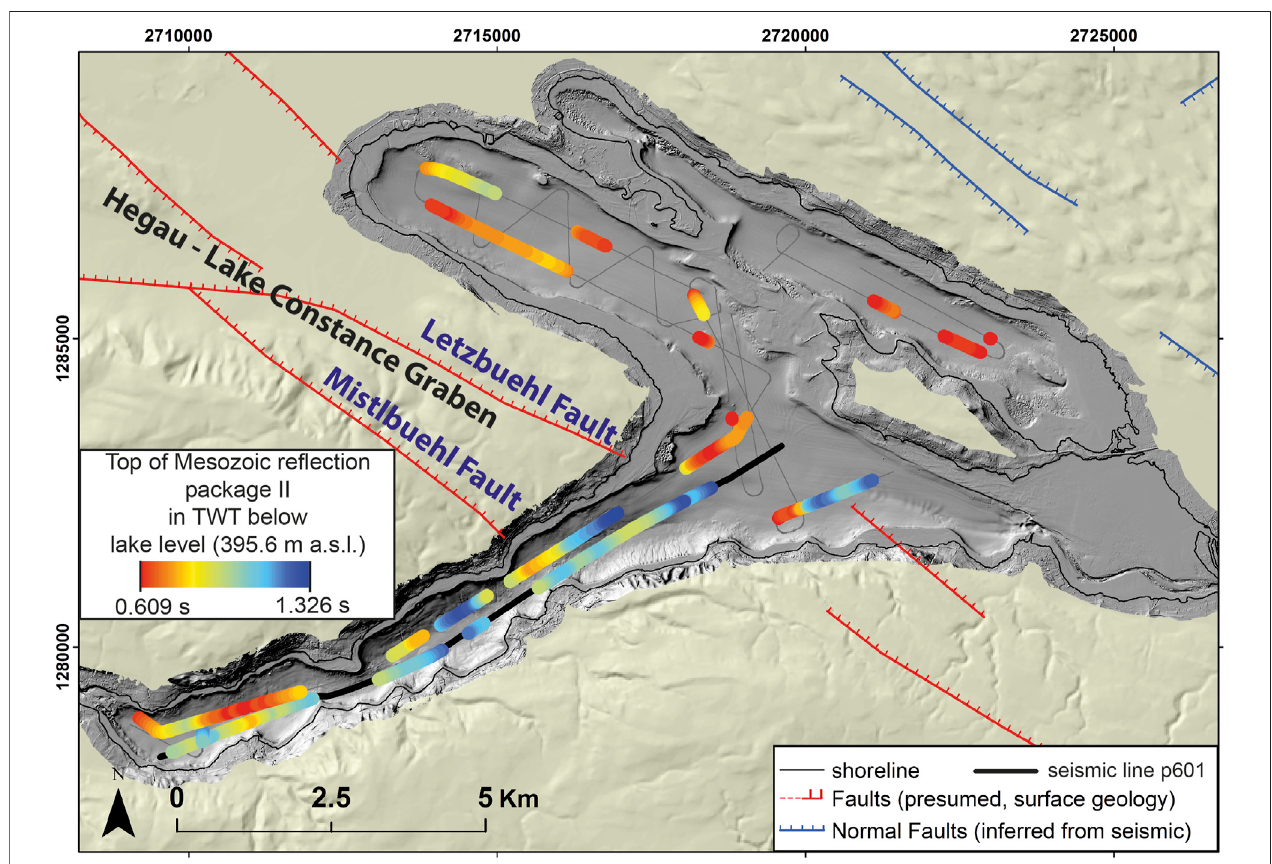
FIGURE 6 | Top of Mesozoic re fl ection package II in two-way travel time (s) with respect to a lake level of 395.6 m a.s.l. and compiled lineaments superimposed in Untersee Basin. Ribbons are only shown for identi fi ed horizons with high con fi dence (solid lines in Figure 4 ).